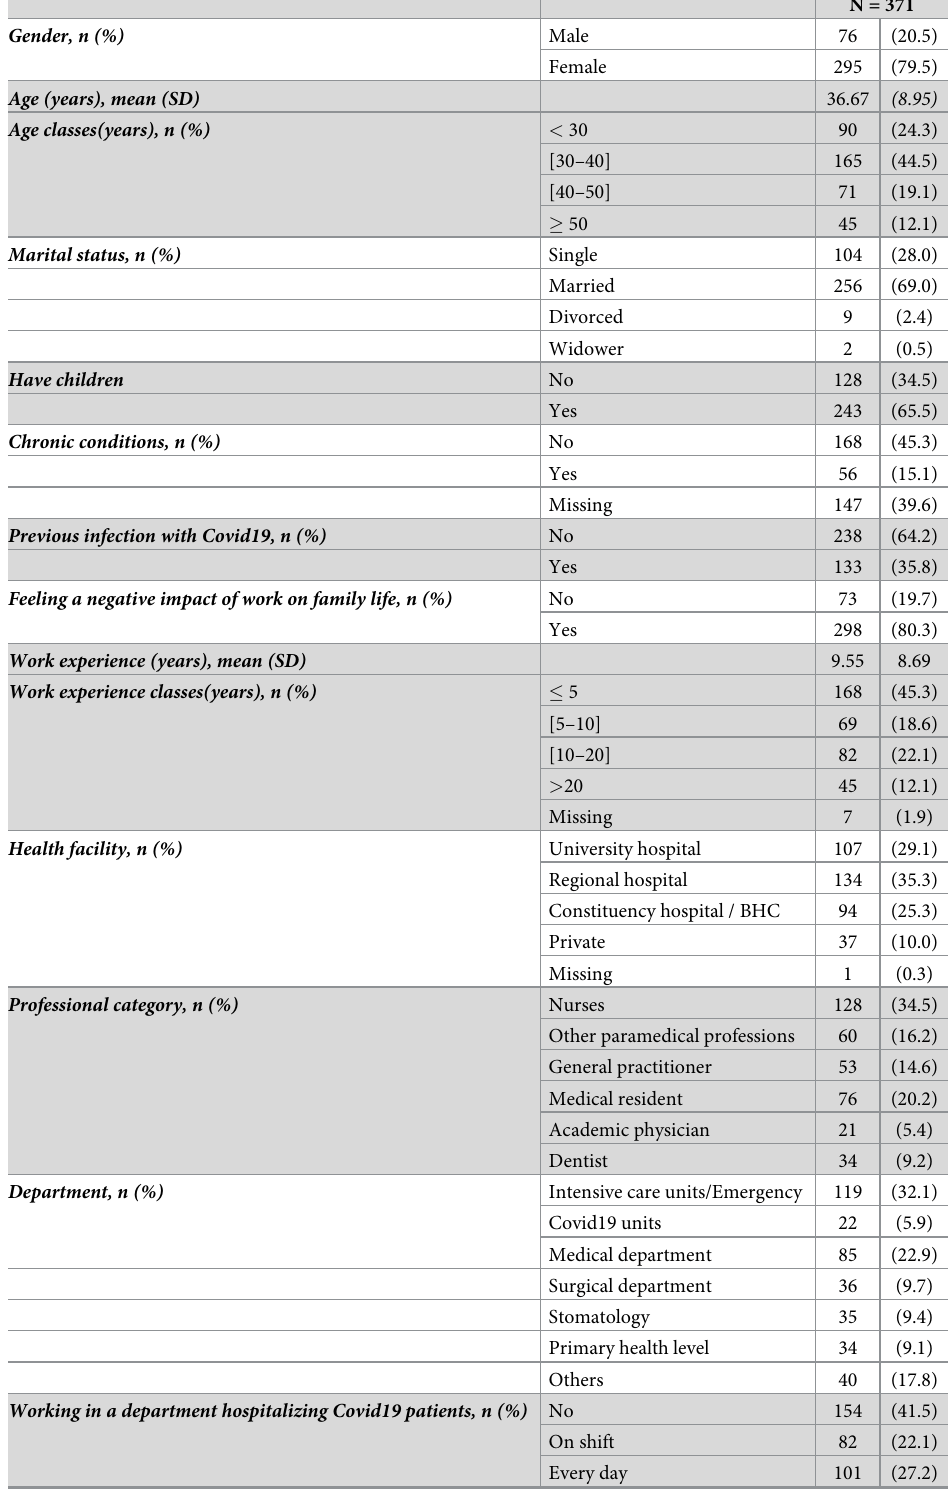
Table 2. General and occupational characteristics of the study